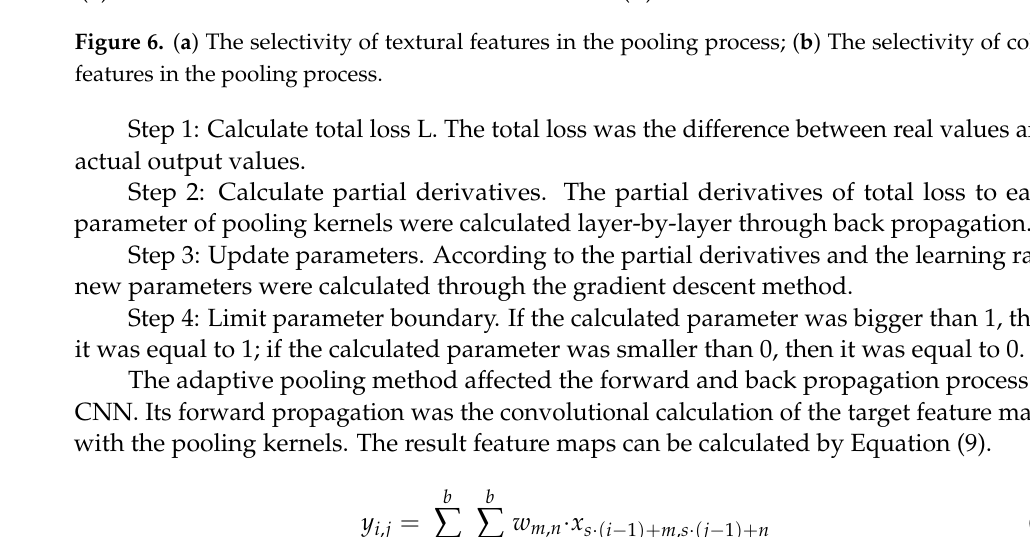
Figure 6. ( a ) The selectivity of textural features in the pooling process; ( b ) The selectivity of color features in the pooling process.